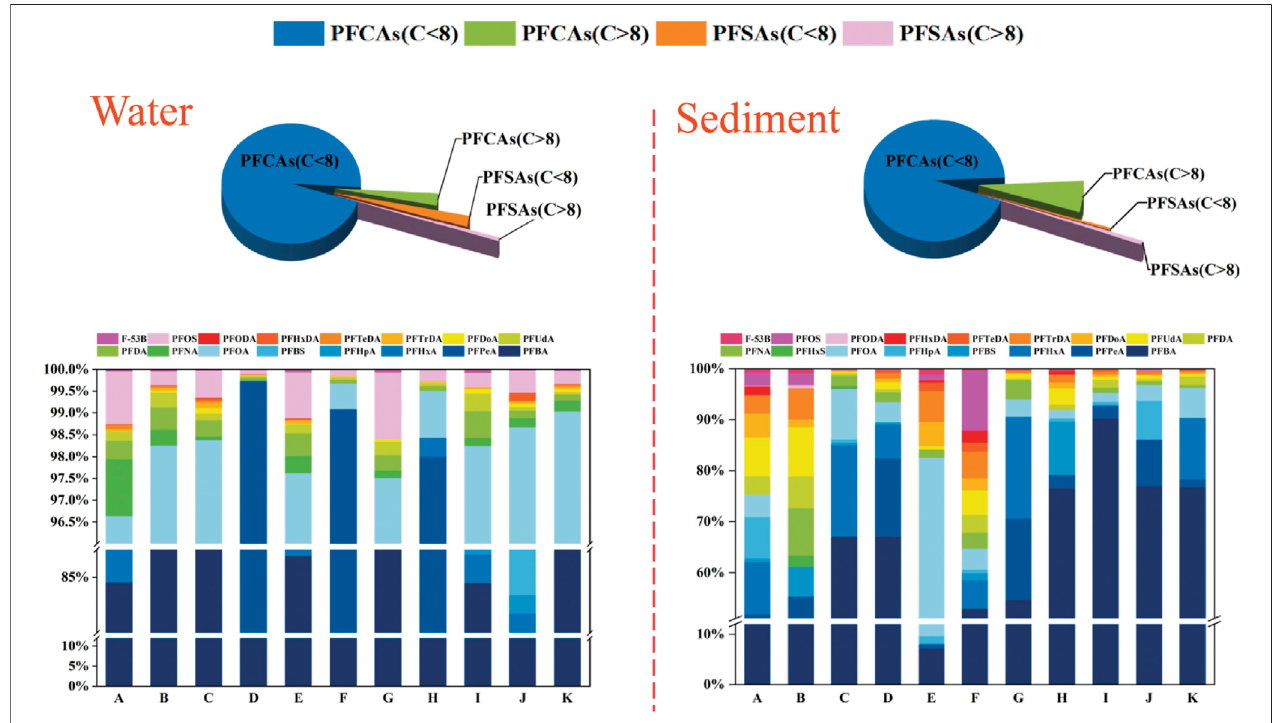
FIGURE 2 | PFASs in water and sediment from the typical bullfrog bases in South China.